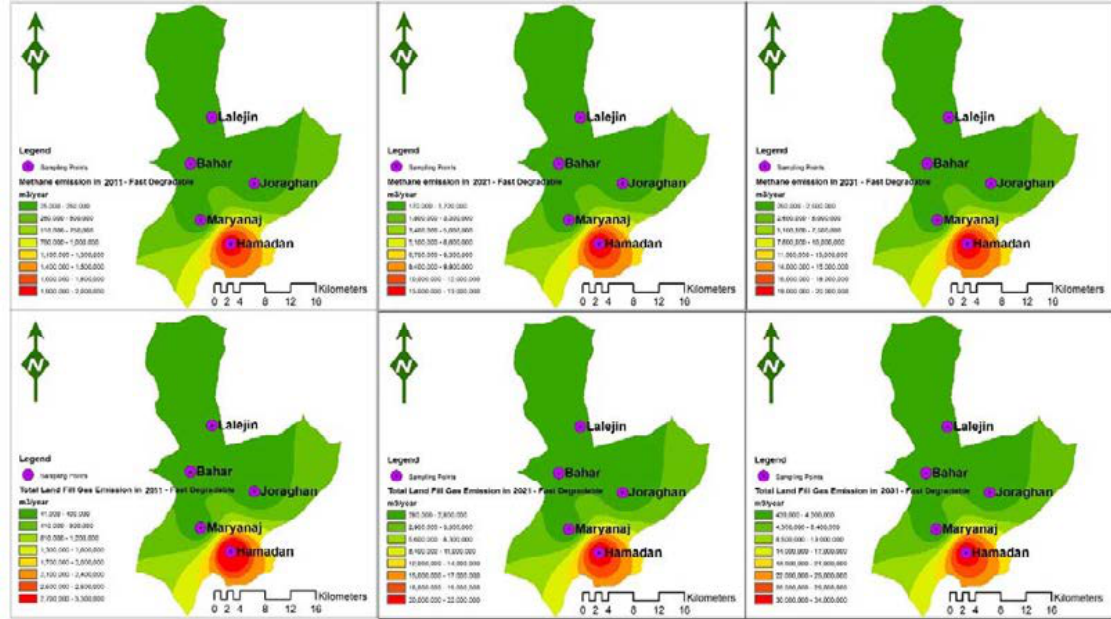
Fig. 8: Spatial distribution of rapidly degradable organic compound, methane and total landfill gas emission in two decades (2011-2021 and 2021-2031) in the study area